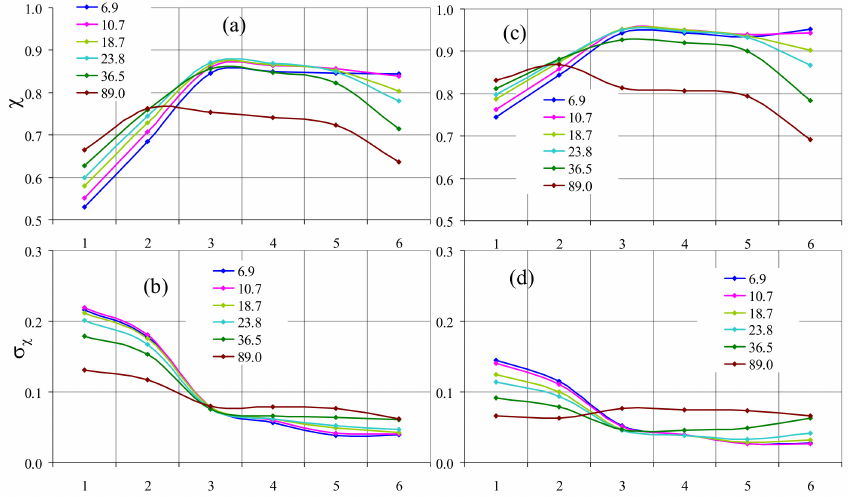
Figure 4. Dependence of winter averaged (calculated on the basis of data for January–May and for November and December 2020) sea ice emission coefficient χ and its standard deviation σ χ on the sea ice type for the AMSR2 channel frequencies: ( a ) χ H ; ( b ) σ H χ ; ( c ) χ V ; ( d ) σ V χ . 1—nilas, 2—young ice, 3—thin FY ice, 4—medium FY ice, 5—thick FY ice, 6—MY